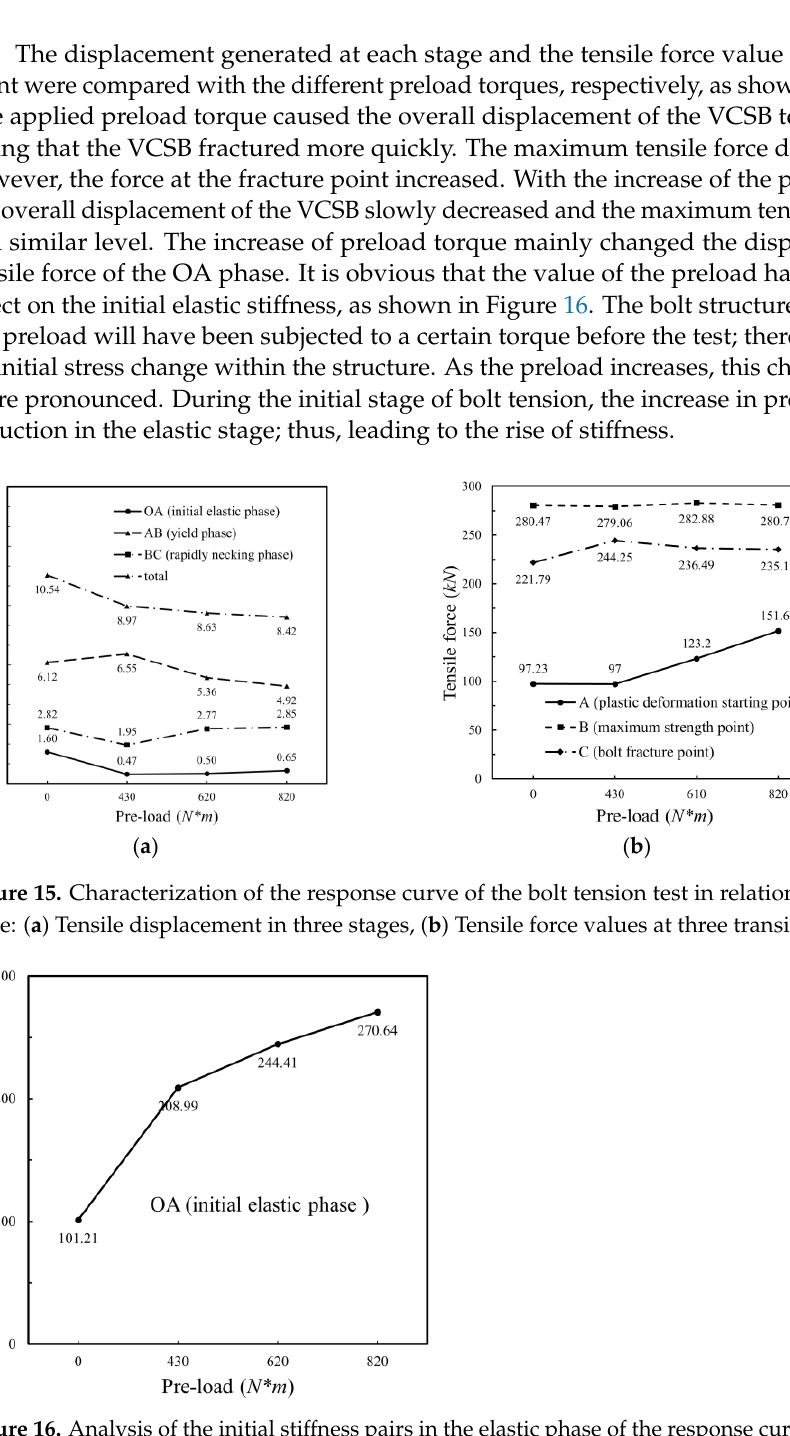
Figure 14. The tensile force and the tensile displacement response curve: ( a ) Test 1 (T P = 0 N ∙ m), ( b ) Test 2 (T P = 430 N ∙ m), ( c ) Test 3 (T P = 610 N ∙ m), ( d ) Test 4 (T P = 820 N ∙ m).